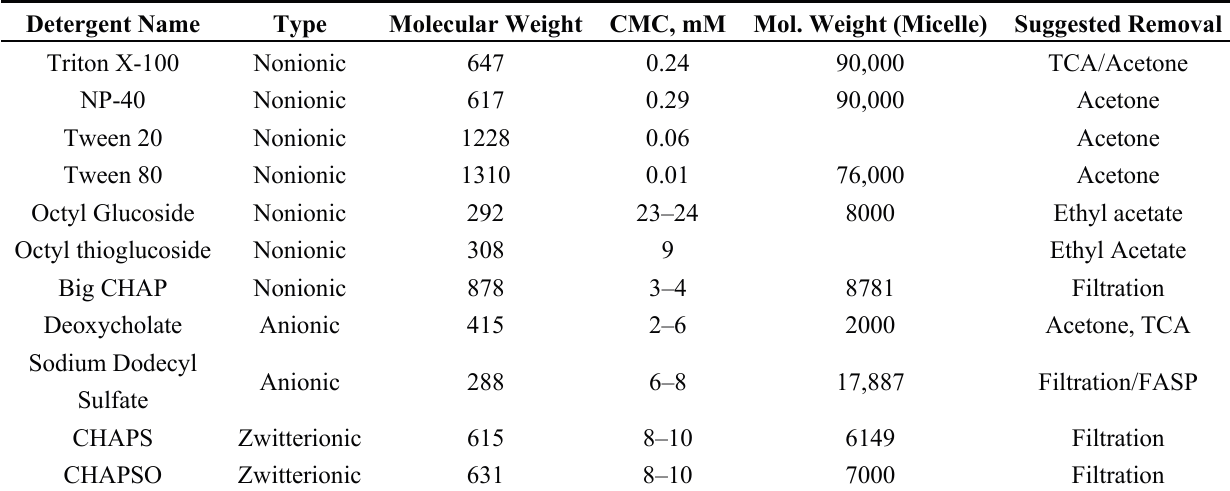
Table 1. Common detergents for mass spectrometry and cell lysis, organized by type. Adapted from Swiderek et al. [41] and Thermo-Pierce